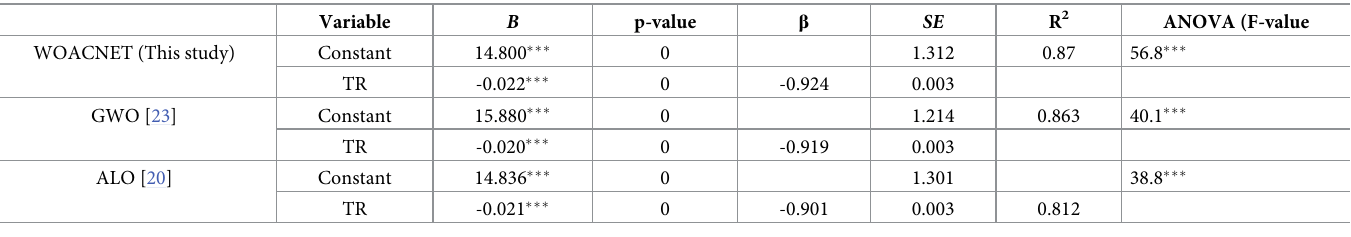
Table 3. Regression coefficients of transmission range on no of clusters.